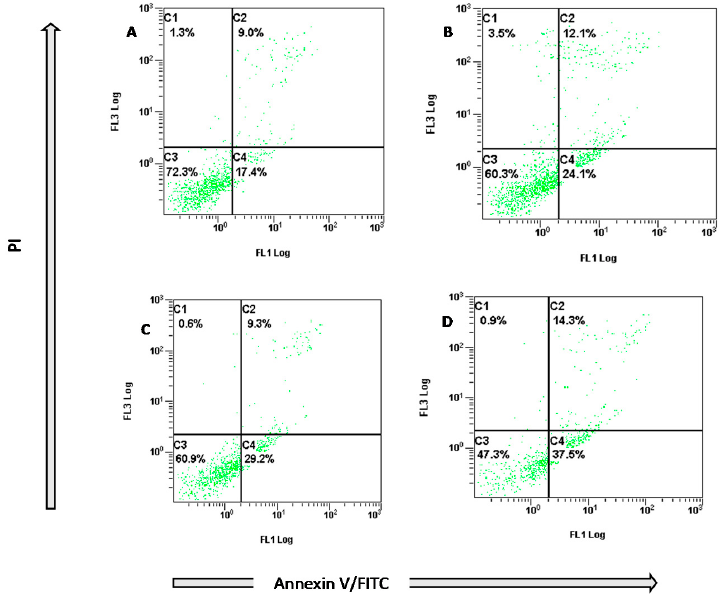
Figure 2. Histogram showing different phases of staining MCF7 cells with annexin V FITC/PI treated with compound 1 (24 h; A: 0, B: 5 µM, C: 10 µM and D: 20 µM). X -axis: annexin V, Y -axis: PI. C1: (necrosis-death, PI+/annexin V − ); C2: (late apoptosis, PI+/annexin V+); C3: (living cells, PI − /annexin V − ); C4: (early apoptosis, PI − /annexin V+). Experiment was repeated 3 × ( n = 3).